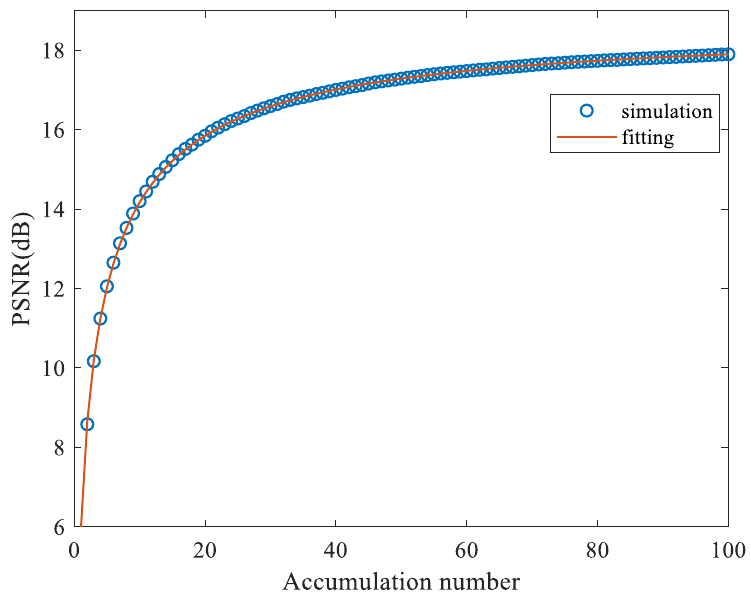
Figure 6. PSNR of the reconstructed image by LRDS binary CGHs ( k = 4) as a function of accumula- tion number. The values of parameters ( S , K ) of the fitting curve are (2.08, 12.79).